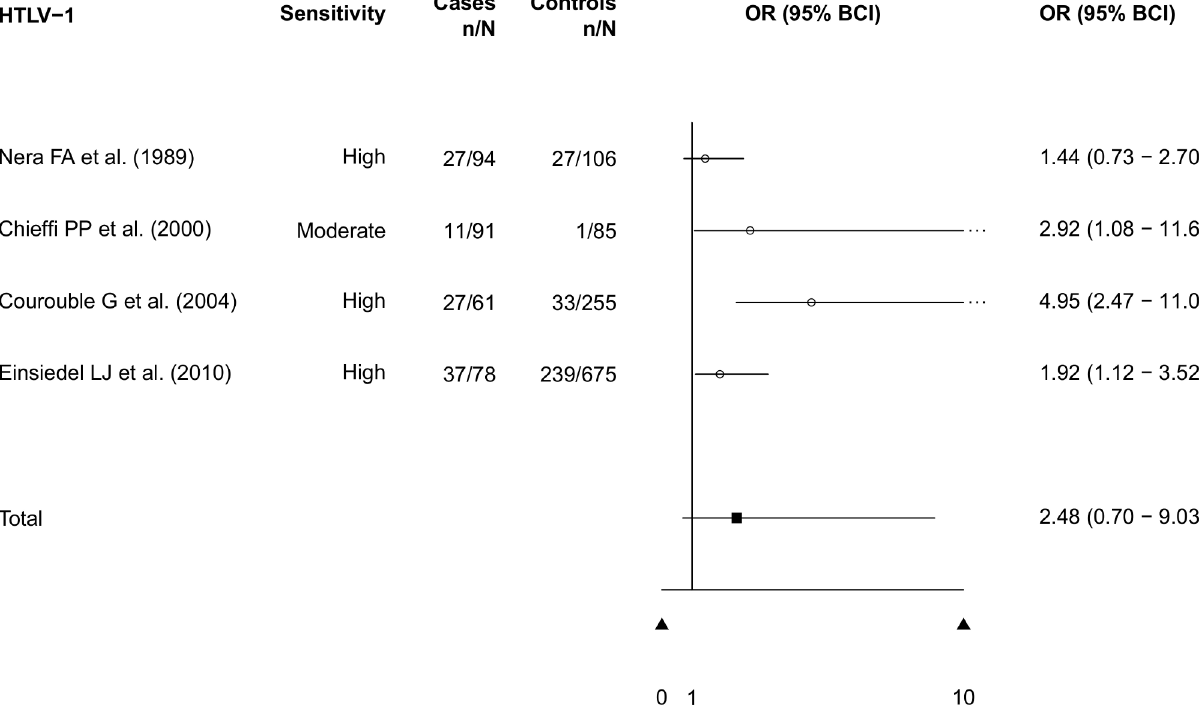
Figure 8. Risk of S.stercoralis infection in patients with HTLV-1 infection (meta-analysis of case-control studies). doi:10.1371/journal.pntd.0002288.g008 PLOS Neglected Tropical Diseases |